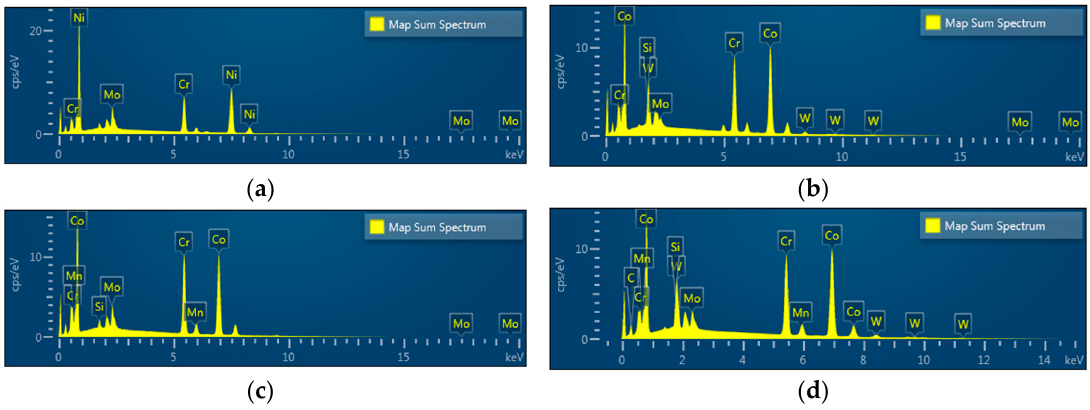
Figure 4. Energy dispersive X-ray spectroscopy (EDS) patterns of the Ni-Cr disk compared with the Co-Cr disk. ( a ) Ni-Cr group, ( b ) Co-Cr (casting) group, ( c ) Co-Cr (milling) group, ( d ) Co-Cr (3D) group.